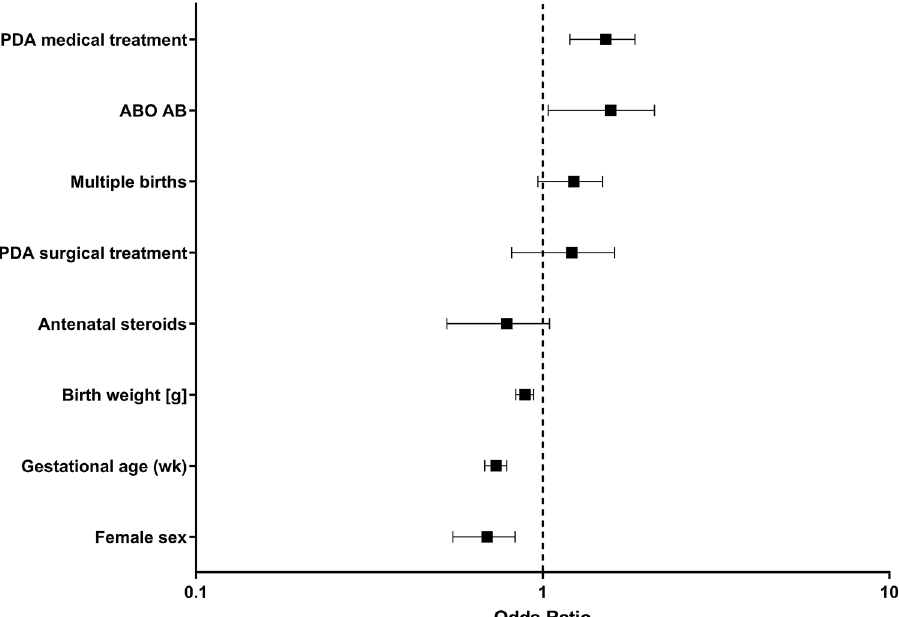
Figure 1. Risk for NEC/FIP—multivariable logistic regression model. Multivariable logistic regression model to adjust the effect of ABO blood group for covariates including multiple births, PDA medical treatment, surgical treatment of PDA, female sex, antenatal steroids, birth weight, and gestational age. The symbols and lines describe odds ratios and corresponding 95% confidence intervals. NEC necrotizing enterocolitis, FIP focal intestinal perforation, PDA patent ductus arteriosus, RDS respiratory distress syndrome.